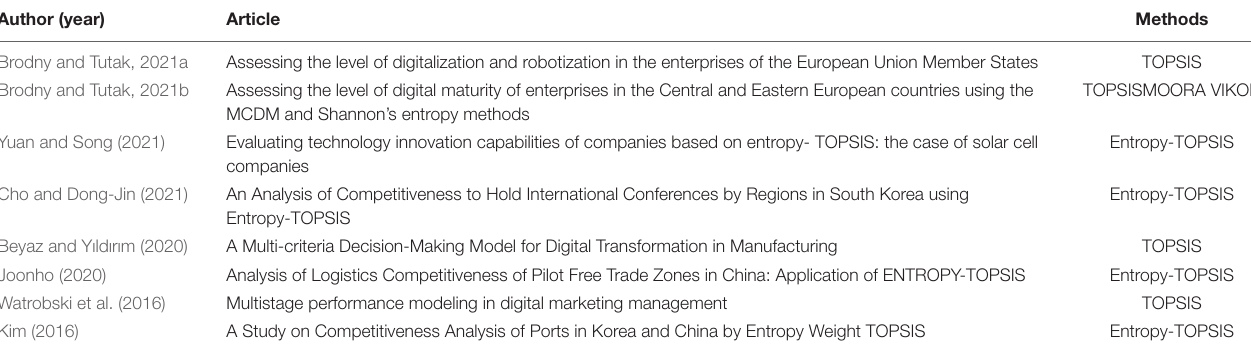
TABLE 2 | Summary of applications of Entropy-TOPSIS methods to solve different problems.